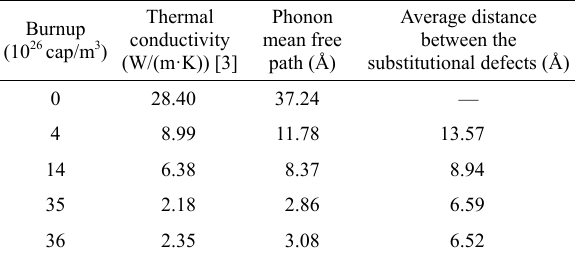
Table 1 Phonon mean free paths estimated from the experimental thermal conductivities [3] at room temperature in comparison with the average distance between the substitutional defects at different burnups Burnup (10 26 cap/m 3 )